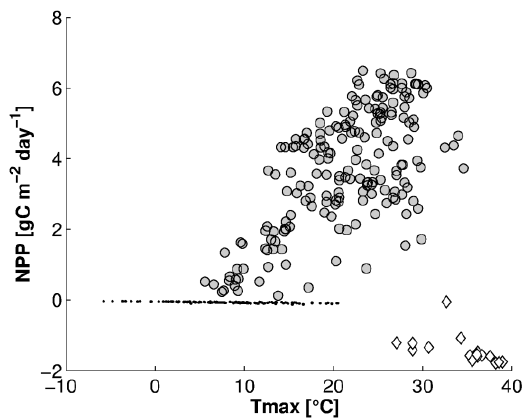
Figure 2. Relationship between NPP and daily maximum temperature (Tmax) for Trier 2003. Filled circles show the normal case of a positive correlation, hollow diamonds show the inverted correlation in stress situations, small points are outside the vegetation period.